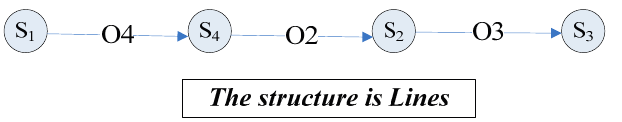
Figure 11. The sensor network structure according to (34).